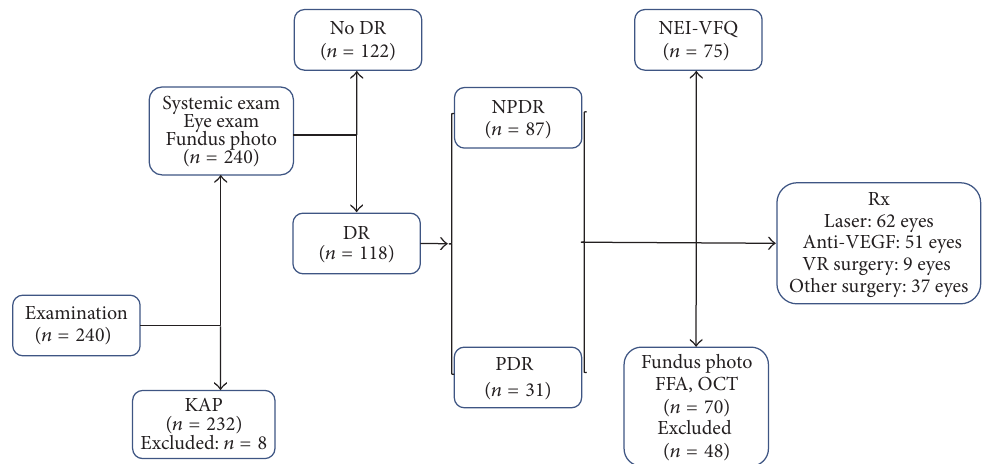
Figure 1: LEADS steps and patients